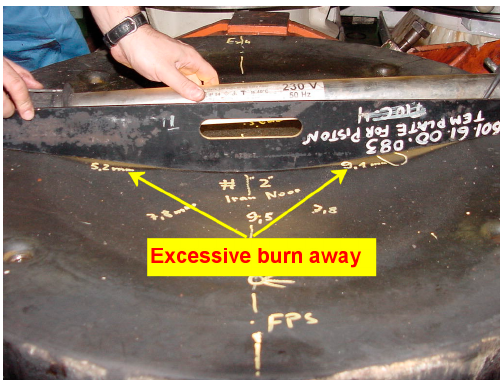
Figure 1. Burn away on spare piston crown.